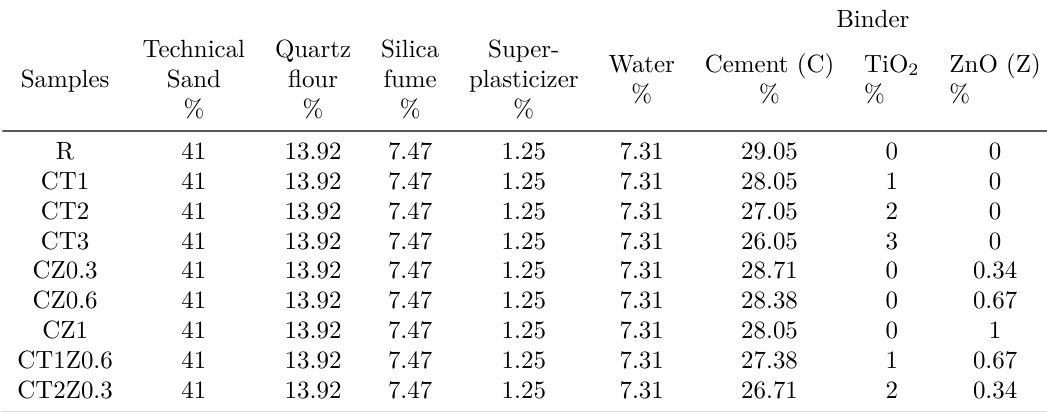
Table 2. Formulation of HPC